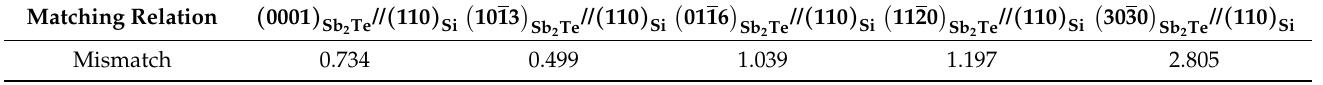
Table 5. Mismatch between the various crystal planes ((0001), Sb 2 Te thin film and the (110) crystal plane of Si substrate.